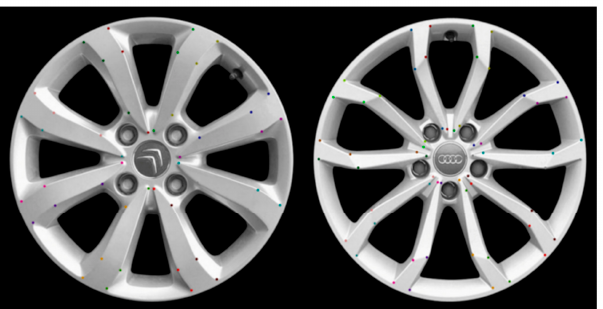
Figure 3. Labeled samples. All samples were labelled using LabelMe to extract feature points on either side of each spoke. In the central area, the position where the trend of the spokes changes was used as the endpoint.